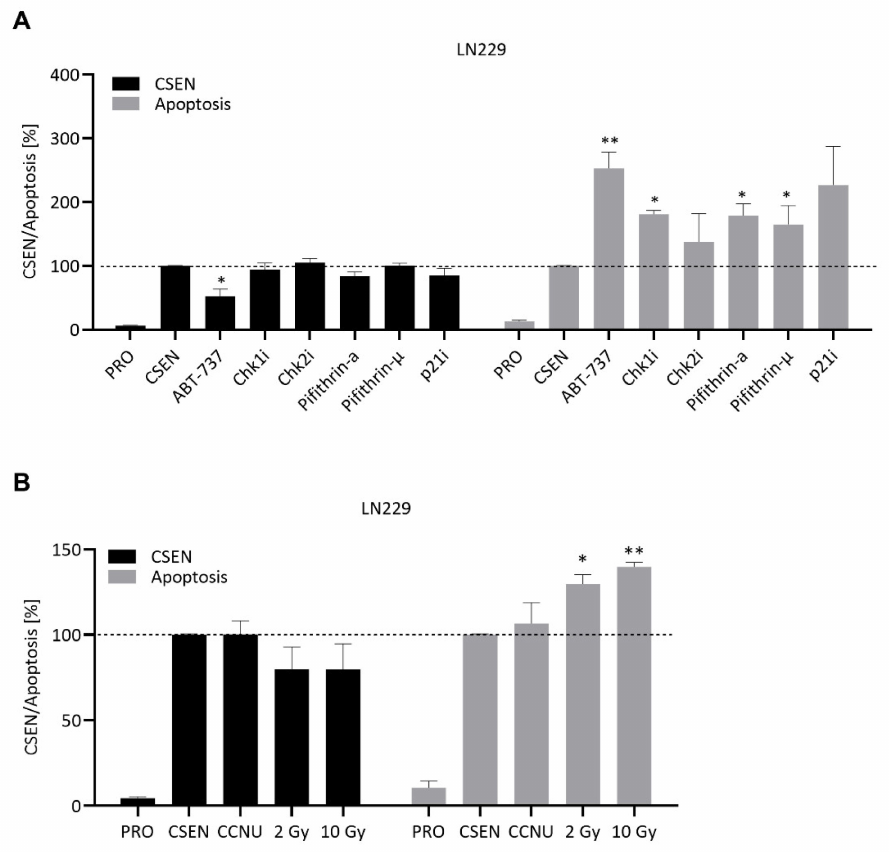
Figure 6. Search for senolytics. Proliferating (PRO) and senescent (CSEN) LN229 and A172 cells were treated with several substances. ABT-737 served as positive control. No senolytic effect was observed when LN229 were treated with the corresponding inhibitors for Chk1/2, p53 or p21 ( A ). A senolytic effect was also not observed upon treatment with CCNU or radiation ( B ). Data represent the mean of >3 independent experiments ± SEM. * p < 0.05, ** p <